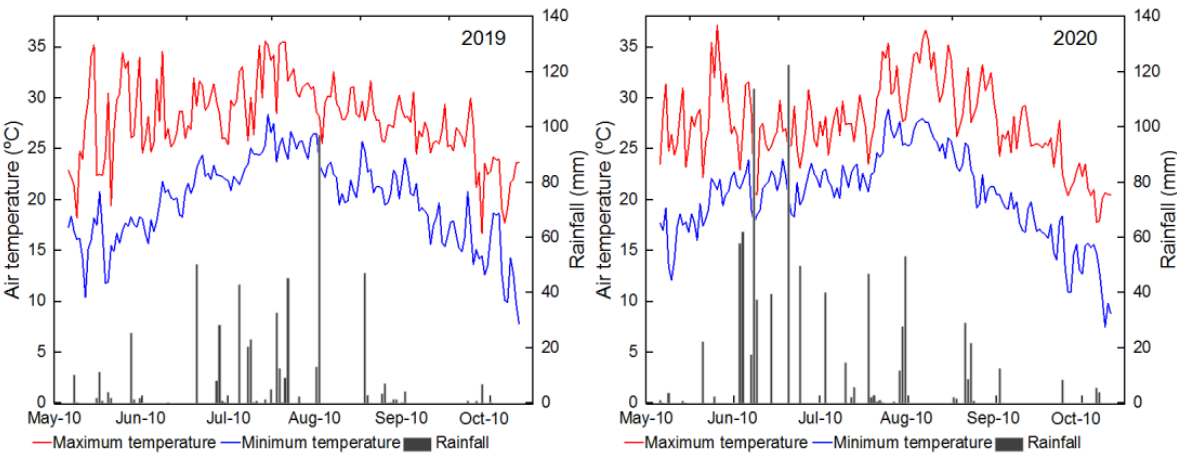
Figure 1. The daily maximum temperature, daily minimum temperature, and rainfall during rice sowing and full-ripening period in 2019 and 2020.